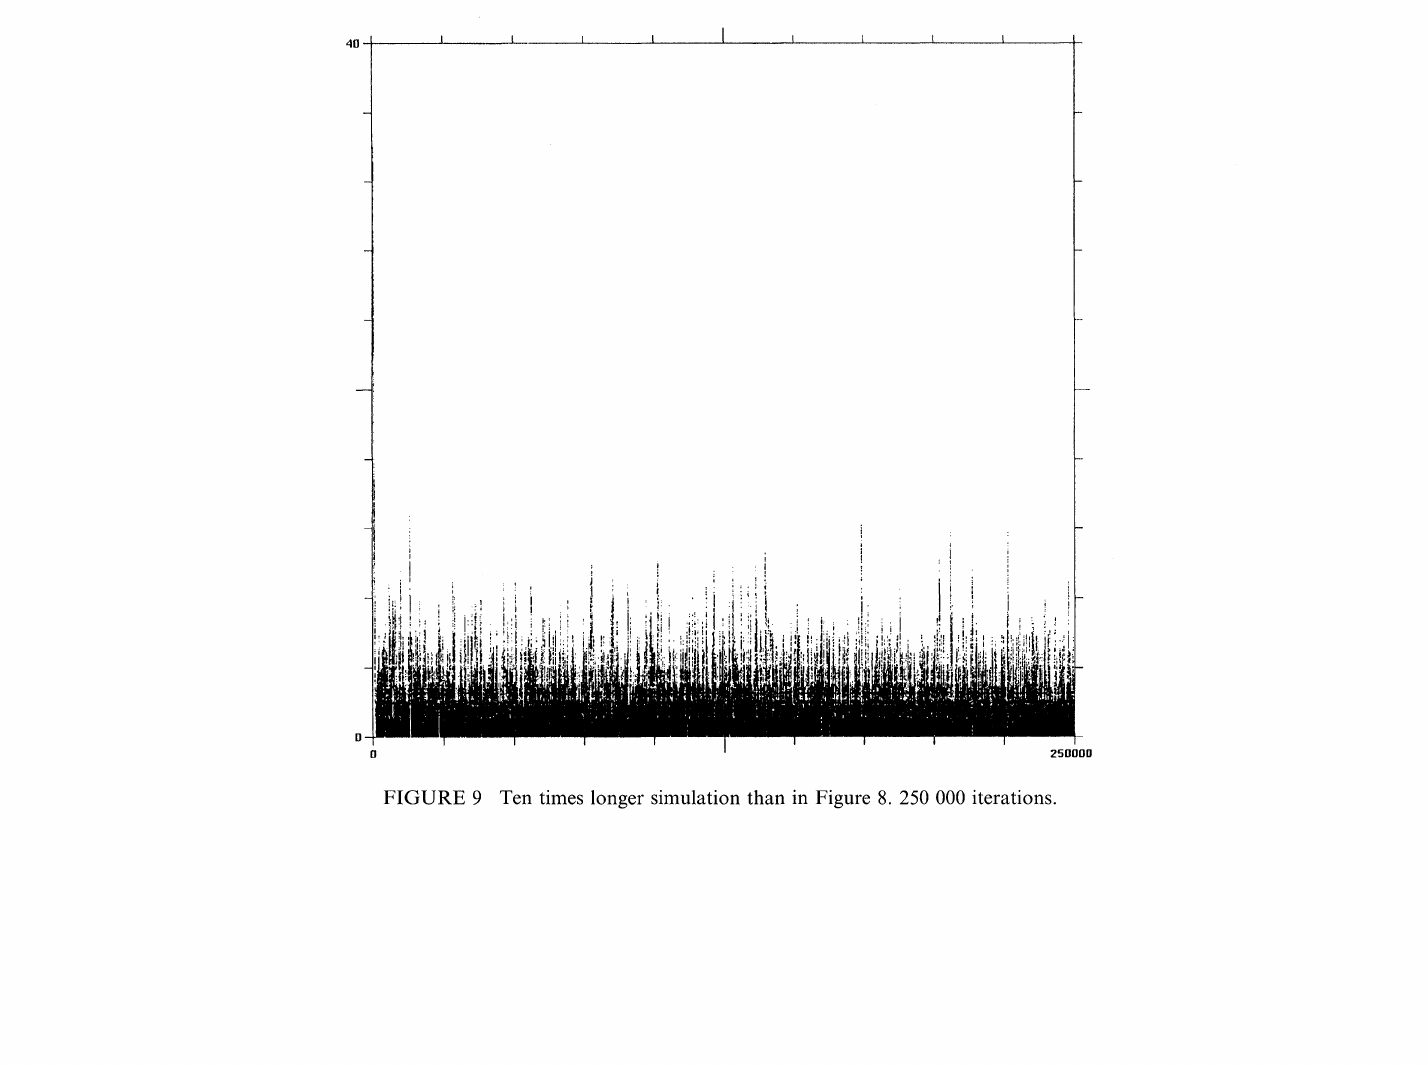
FIGURE 9 Ten times longer simulation than in Figure 8. 250 000